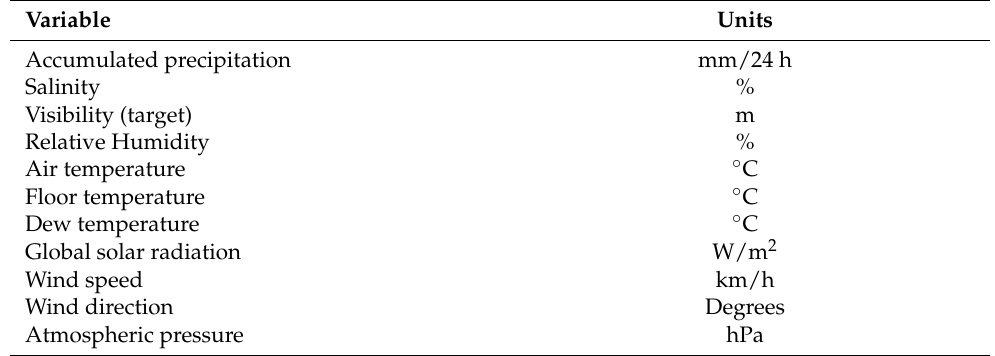
Table 1. Description of the prediction (input) variables in the database for fog events description and forecasting at Mondoñedo, Galicia,